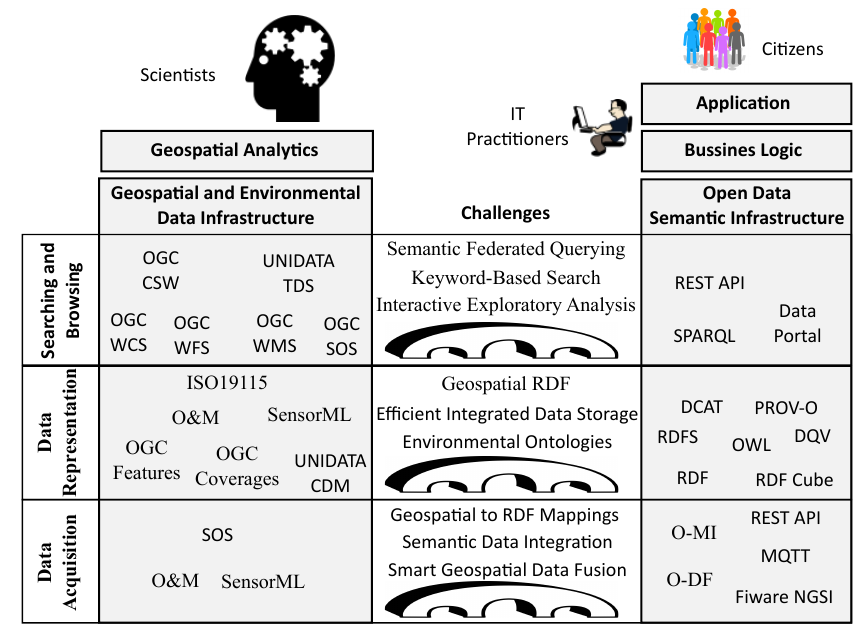
Figure 1. Research challenges to bridge the gap between geospatial and conventional open data